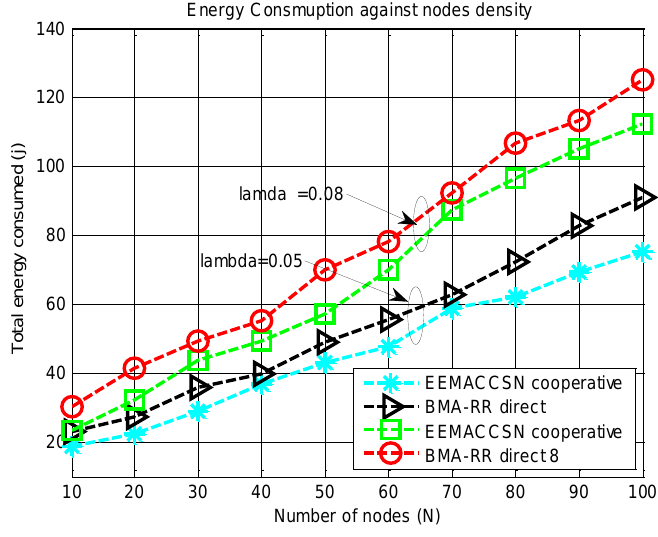
Figure 13. Energy consumption against number of